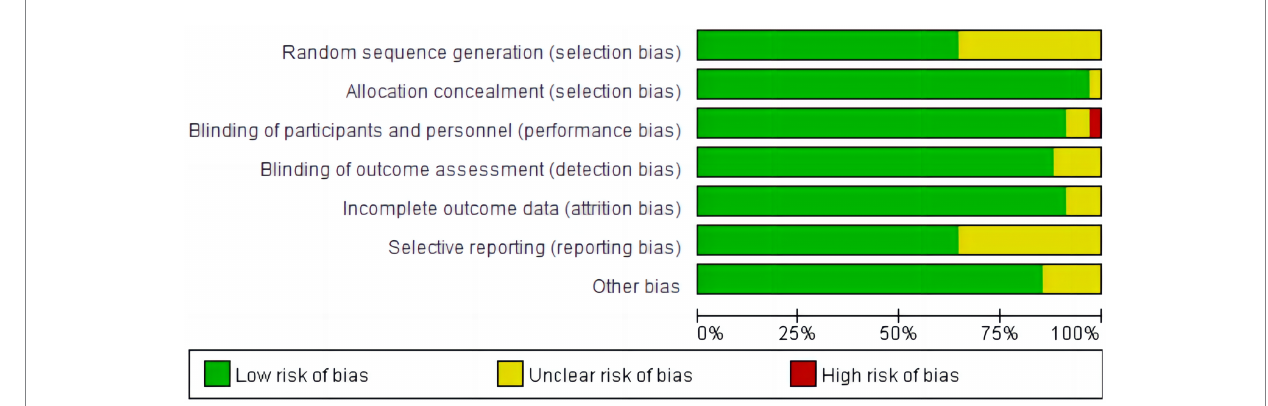
FIGURE 1 Risk of bias graph: review authors’ judgments about each risk of bias item, presented as a percentage of included